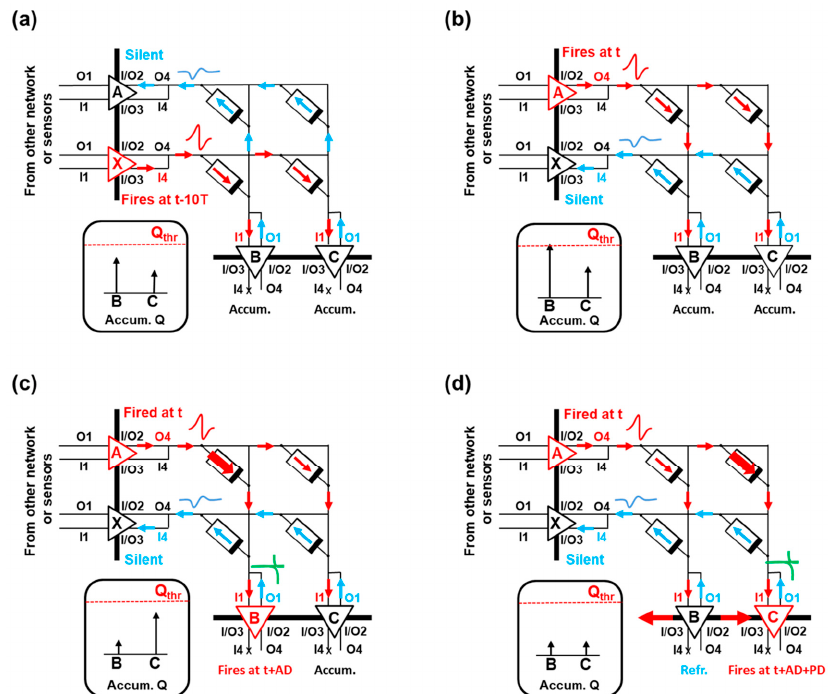
Figure 11. Sketch of the 2 × 2 crossbar array operation. ( a ) Input neuron X fires a pulse through Out4, and input neuron A remains silent. ( b ) Input A fires a pulse, and output neuron B accumulated charge reaches the charge threshold, Q thr . ( c ) The accumulated charge of B is reset, and B fires a pulse delayed by AD with respect to the firing time of A. ( d ) Neuron B communicates with its neighbors (only C is depicted). Neuron C triggers a pulse delayed AD + PD with respect to the firing time of A, and its accumulated charge is